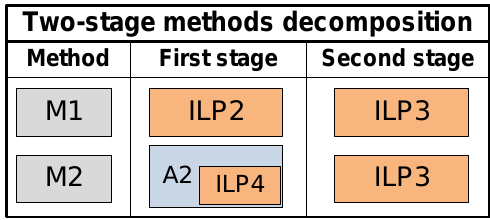
Figure 5. Two-stage method